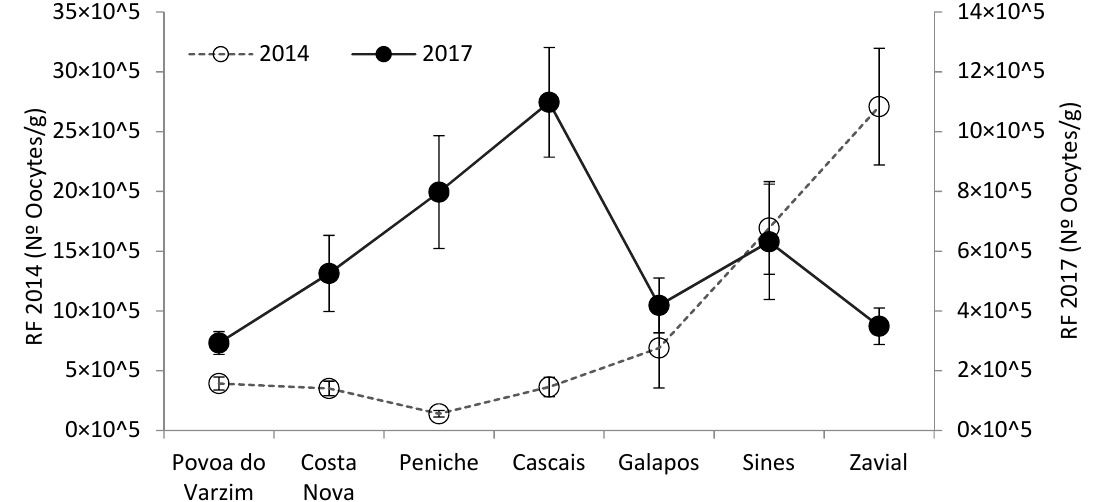
Figure 4. Average and standard error of relative fecundity (RF, n°. oocytes per gram of gonad) in the different locations along the Portuguese coastline, from North (left) to South (right), during the years of 2014 and 2017.